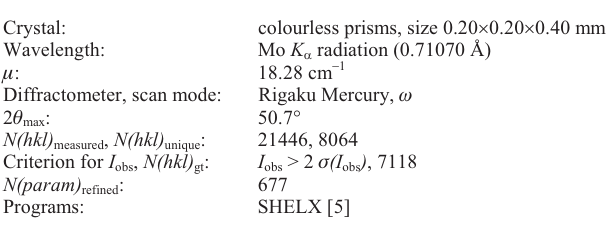
Table 1. Data collection and handling.